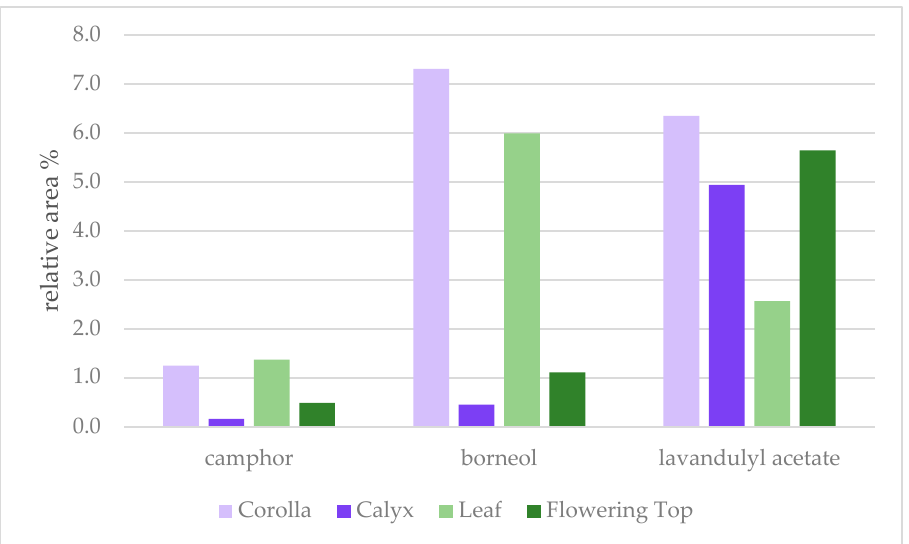
Figure 2. Relative area % of camphor, borneol, and lavandulyl acetate in each portion of L. angustifolia , namely the corolla, calyx, leaf, and whole flowering top. The profiles of the calyx and whole flowering top are similar. Despite the low yield of the corolla and leaf, both portions impact the profile of the whole flowering top.